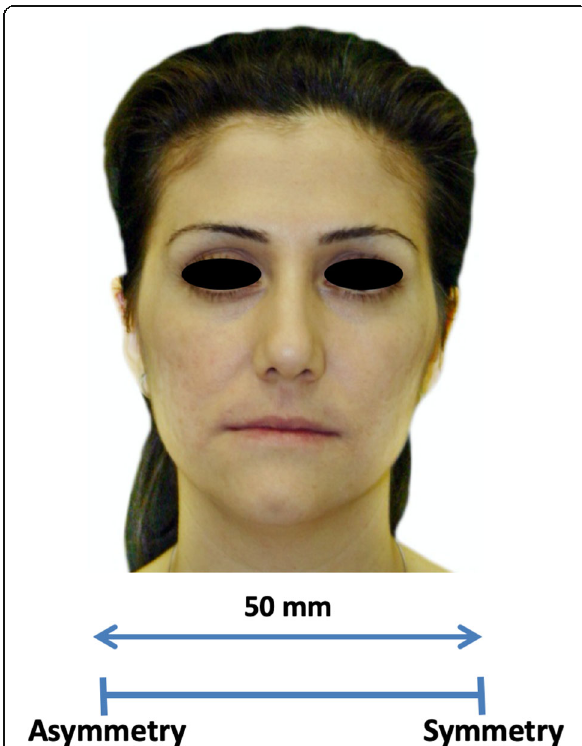
Fig. 2 Visual analog scale (VAS) used to score facial symmetry ranging from “ most asymmetric ” (0 mm) on the left to “ most symmetric ” (50 mm) on the